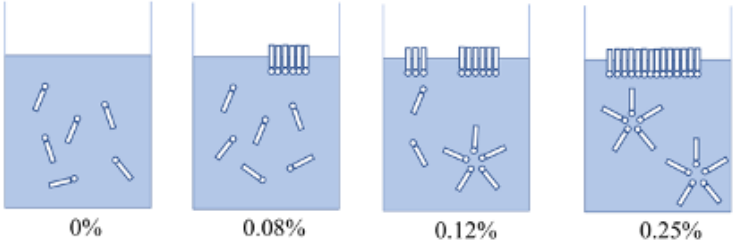
Figure 1. Micelle formation and surface adsorption of surfactants at different concentrations. Table 2. Main surfactants used for the production of microbial pesticides.